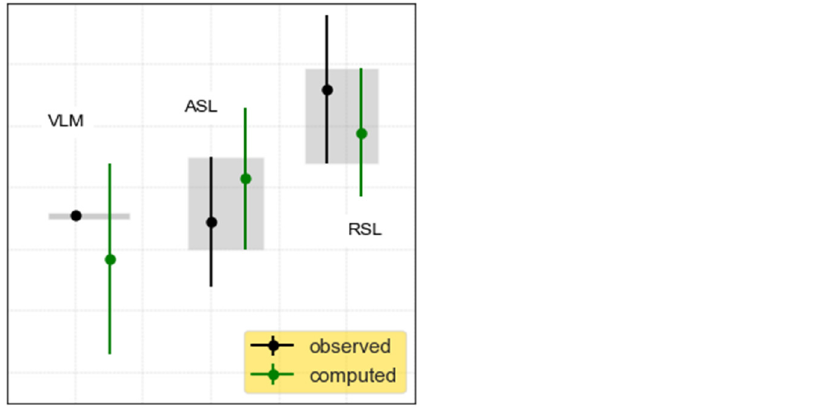
Figure 7. The comparison of linear trend estimates from observed data (black) and those computed (green) at Porto Garibaldi. Dots represent the central values with their standard deviation depicted by the line. Grey areas show the common interval between the different datasets trend values. It can be noted that the values of the observed and computed trends match within their error bars.